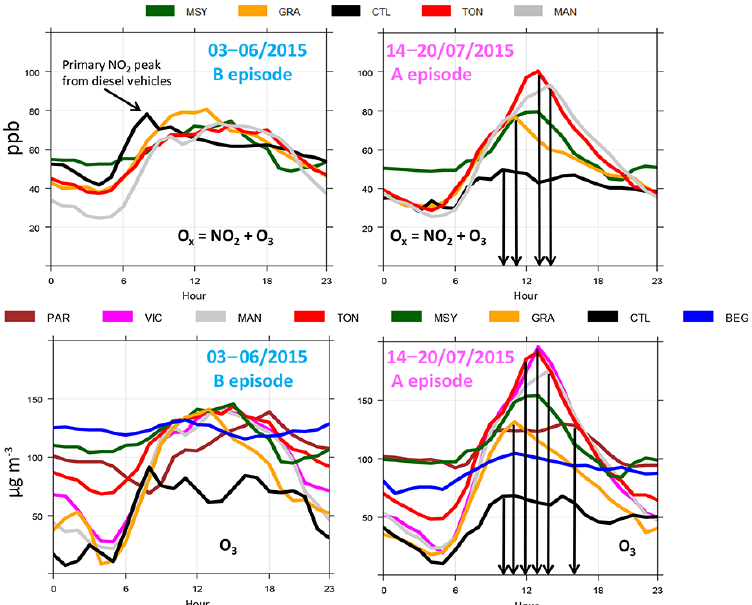
Figure 8. Mean hourly levels of O 3 and O x (O 3 + NO 2 ) for sites in a south (coast) to north (inland) transect (CTL, GRA and BEG, and MSY, TON, VOIC, MAN and PAR, respectively) following the inland transport of pollutants from the coast, and maxima time shift according to the sea-breeze transport (right) for the periods 3–6 July 2015 (B type episode, left) and 14–20 July 2015 (type A episode, right). Time is